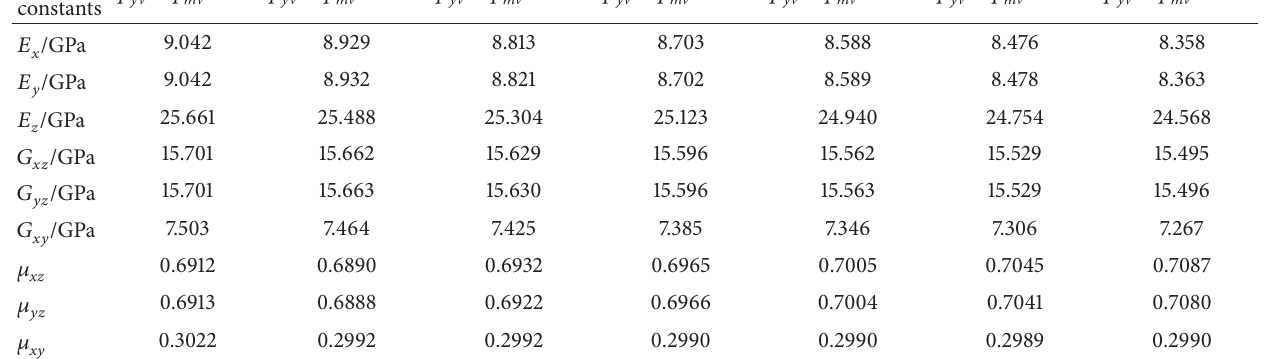
Table 6: Effect of 𝑝 𝑦 V (or 𝑝 𝑚 V ) on the elastic properties of specimen number 2.